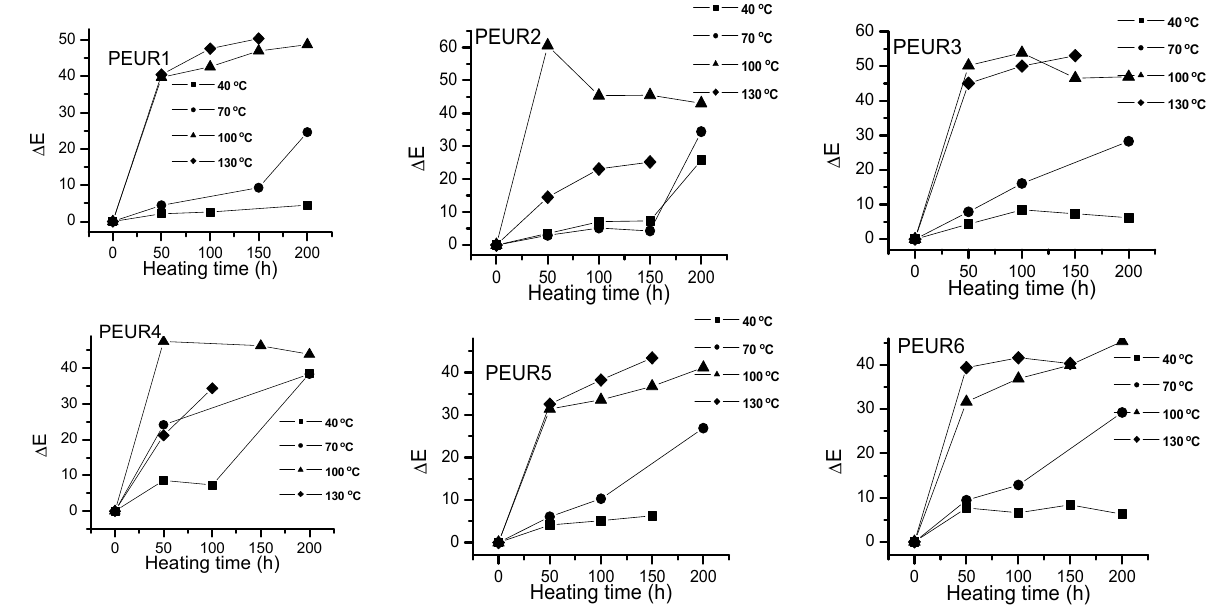
Figure 4. Variation of Δ b * with temperature and heating time of PEURs. Figure 5 shows the Δ E variation with temperature and heating time of the studied samples. The PEURs resisted up to 150 h thermal aging time, after which they became sticky or completely degraded, making color determinations difficult.